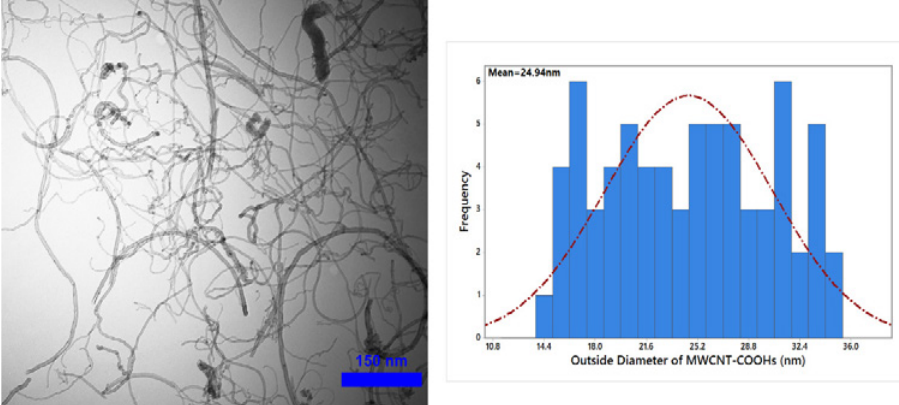
Fig. 2. TEM image and histogram of the outside diameter of the MWCNT-COOH. Figure 2. TEM image and histogram of the outside diameter of the MWCNT-COOH.